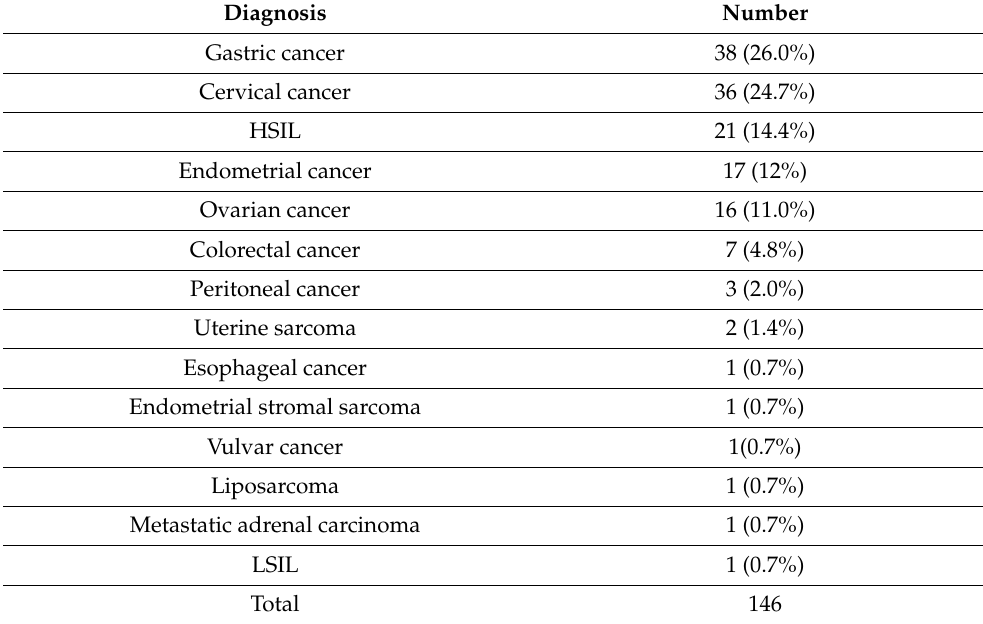
Table 1. Number of non-breast malignancy cases and healthy volunteers used as